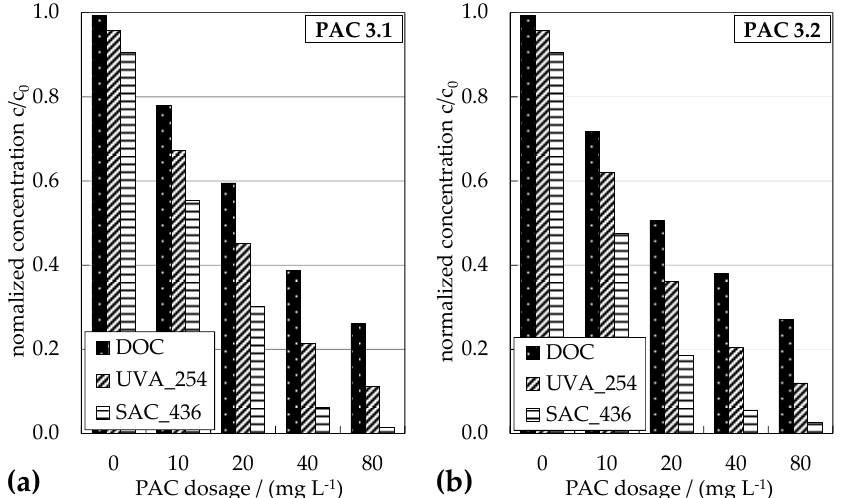
Figure 6. Ultrafiltration with pre-deposition of milled PACs at varying concentrations. Normalized average concentration of DOC, UVA 254 and SAC 436 dependent on applied carbon concentration of ( a ) PAC 3.1 and ( b ) PAC 3.2. (Membrane: 150 kDa; PES; 2.87 × 10 − 3 m 2 ; V F = 500 mL; n = 2–3).